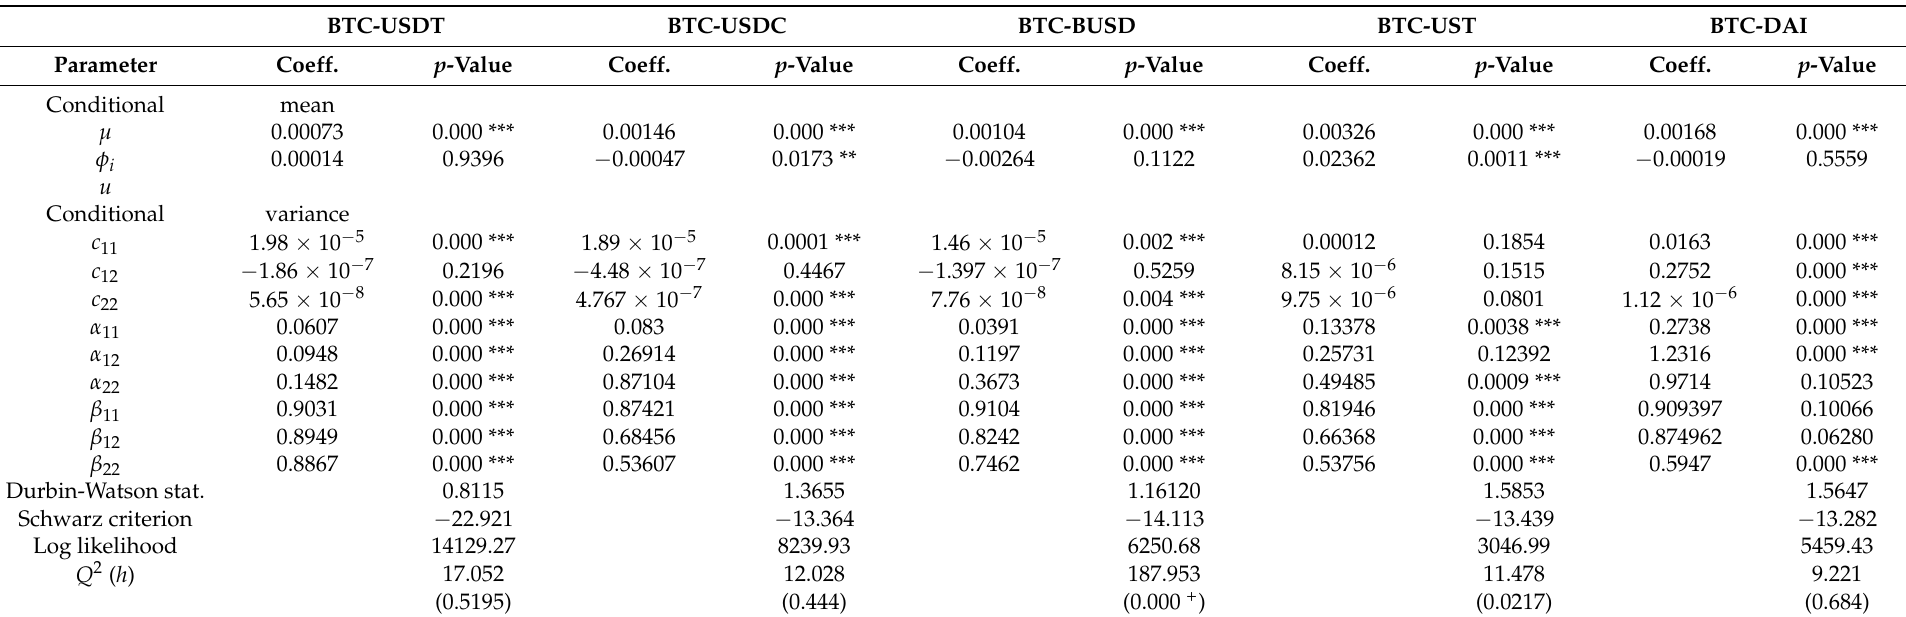
Table 3. The results of the bivariate BEKK-GARCH model parameter